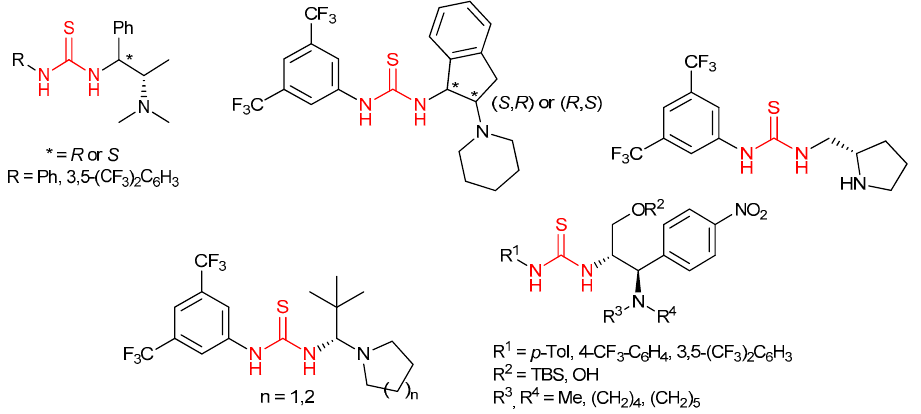
Figure 14. Chiral thioureas based on various diamines [187–193].